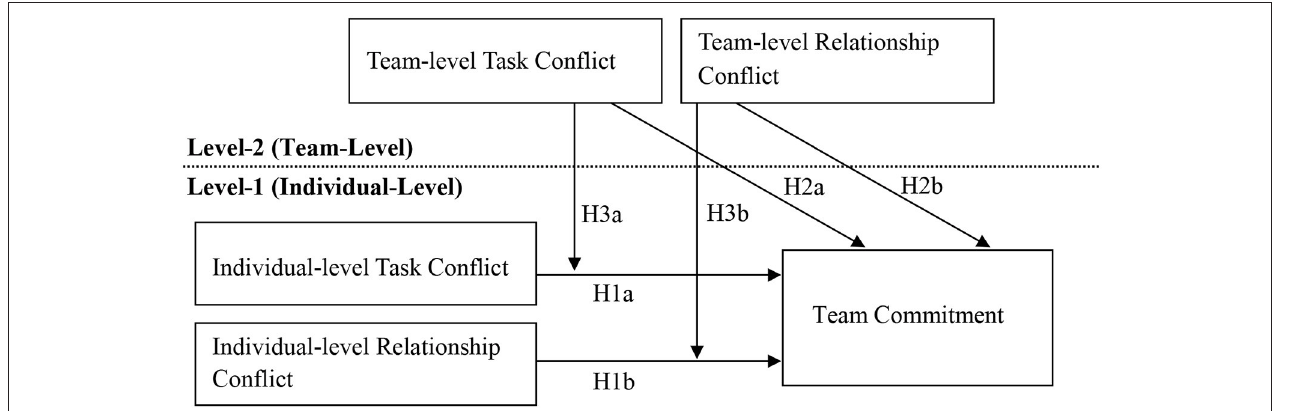
FIGURE 1 | Hypothesized multilevel model of the intragroup